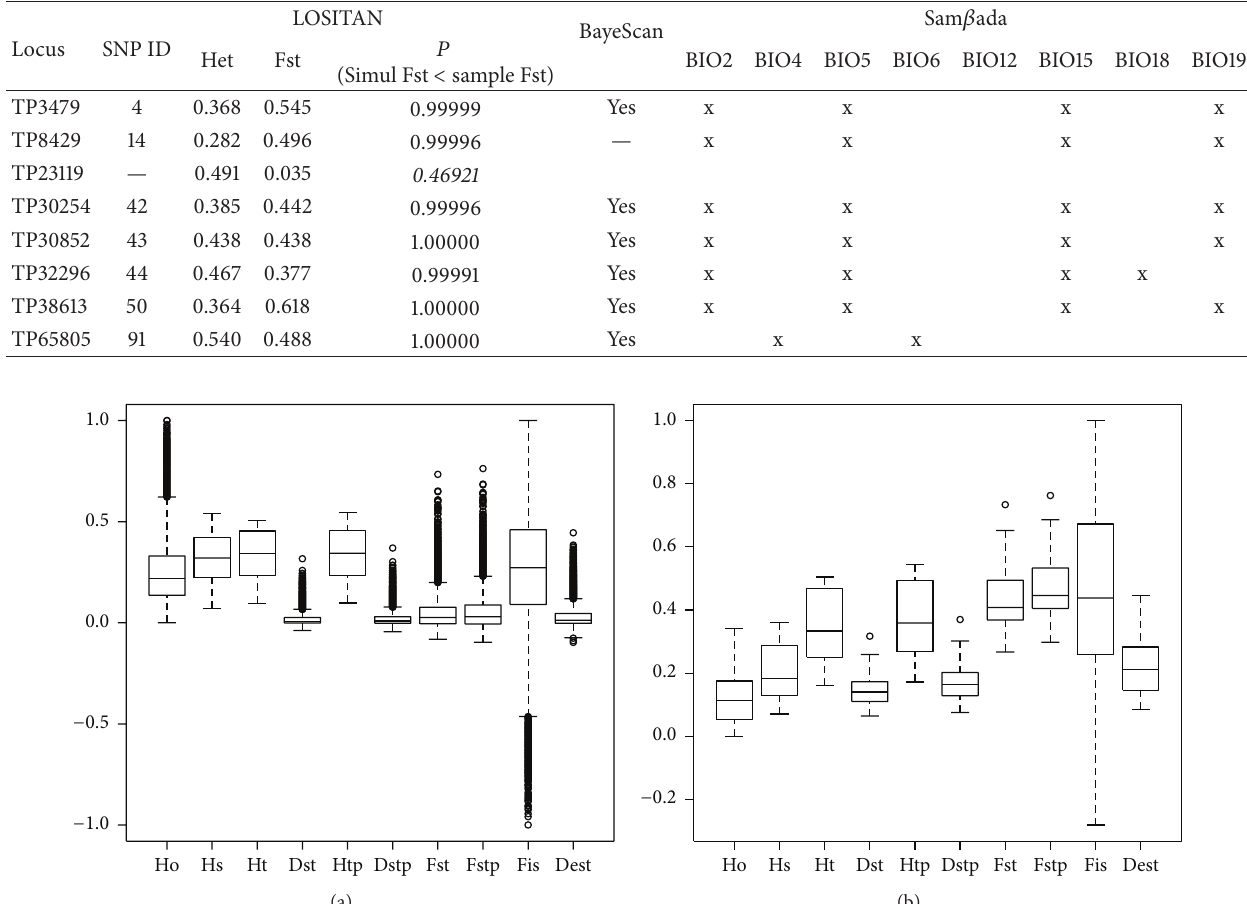
Table 2: Representative list of outlier single nucleotide polymorphisms (SNP) as putative candidates for adaptation in Nothofagus dombeyi in Chile and their significant associations with environmental variables using Sam 𝛽 ada. Italic values show an SNP that is not a significant outlier.